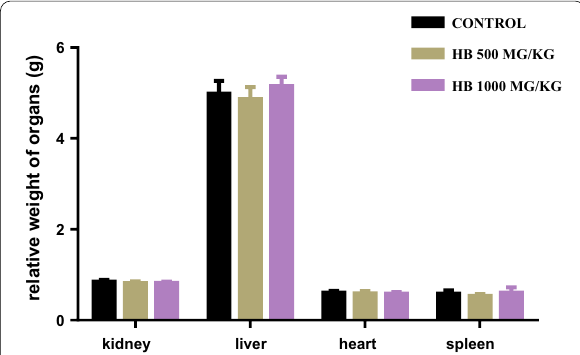
Fig. 1 Relative organ weight compared by ANOVA 2‑WAYS followed by Turkey’s Test ( n =